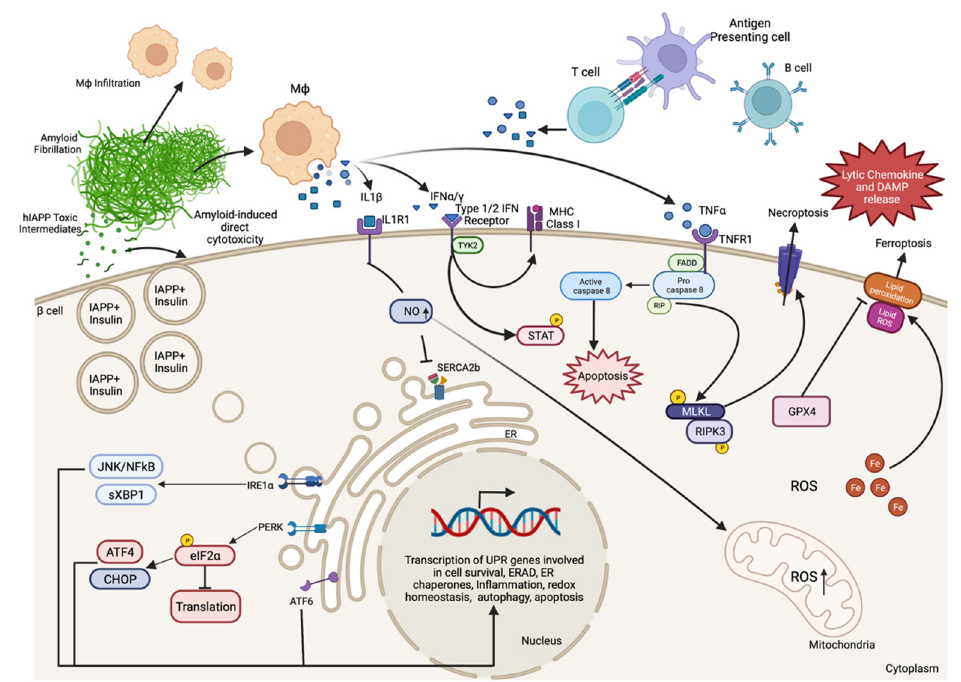
Figure 1. Schematic model of diabetes-relevant mechanisms of β -cell death. Several mechanisms of β -cell death discussed in this review, including autoimmune-associated, islet amyloid-induced, proinflammatory cytokine-mediated, and ER stress- and oxidative stress-induced β -cell death are illustrated in this diagram. This model represents an integrated, but simplified and incomplete graphical representation of diabetes-associated mechanisms of β -cell death.